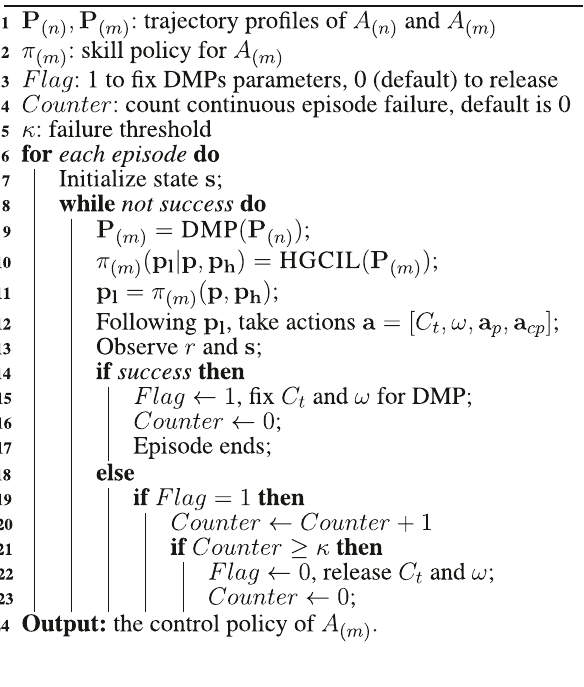
Algorithm 1 | Modular learning